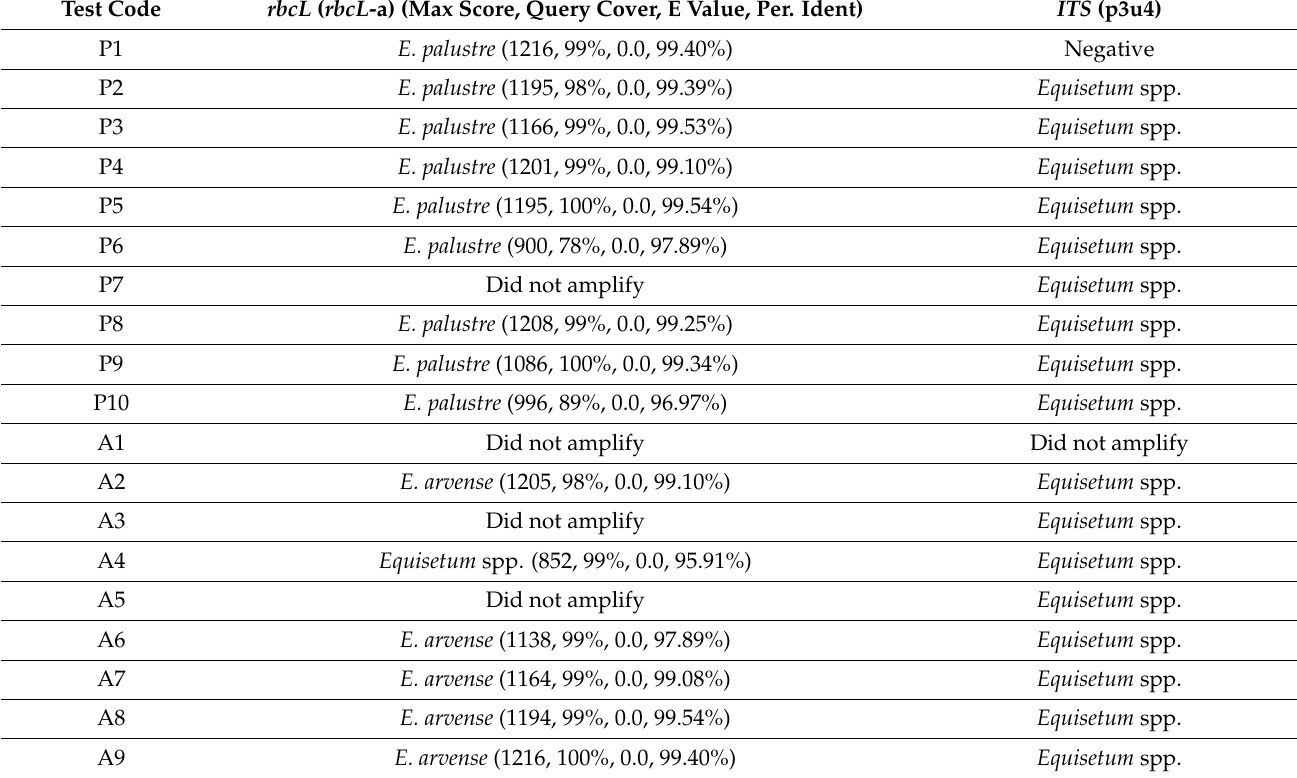
Table 3. The DNA barcoding results for each horsetail sample corresponding to each gene marker. Included were the Max Score, Query Cover, E value and Per. Ident (Percent Identity) of the topmost BLAST match for each sample, using the rbcL marker, which frequently allowed us to distinguish between E. palustre and E. arvense . A negative result refers to samples that identified with a plant outside of the Equisetum genus of the horsetail family. The primer pair used for each marker is shown in parentheses. p3u4 denotes the ITS-p3 + ITS-u4 primer